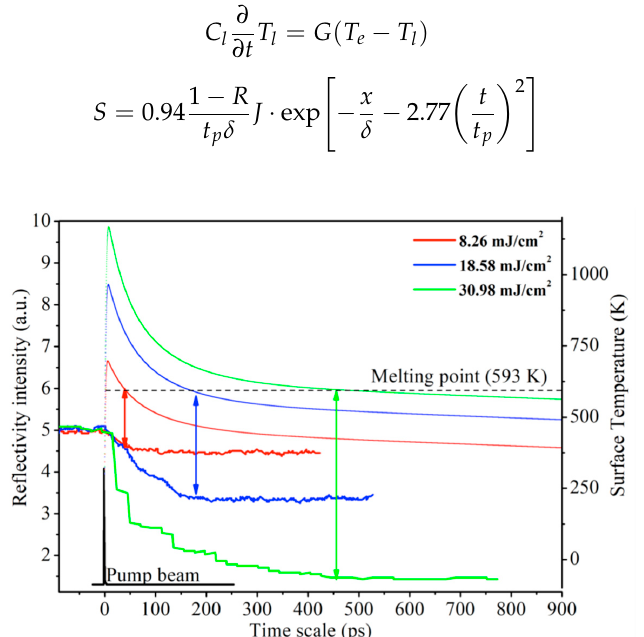
Figure 3. The pump-probing reflectivity signals of laser-induced ablation of As 2 S 3 with different laser fluences in scatter-lines, and the corresponding simulated surface temperature as a relationship of time for the applied incident laser intensity in solid lines.